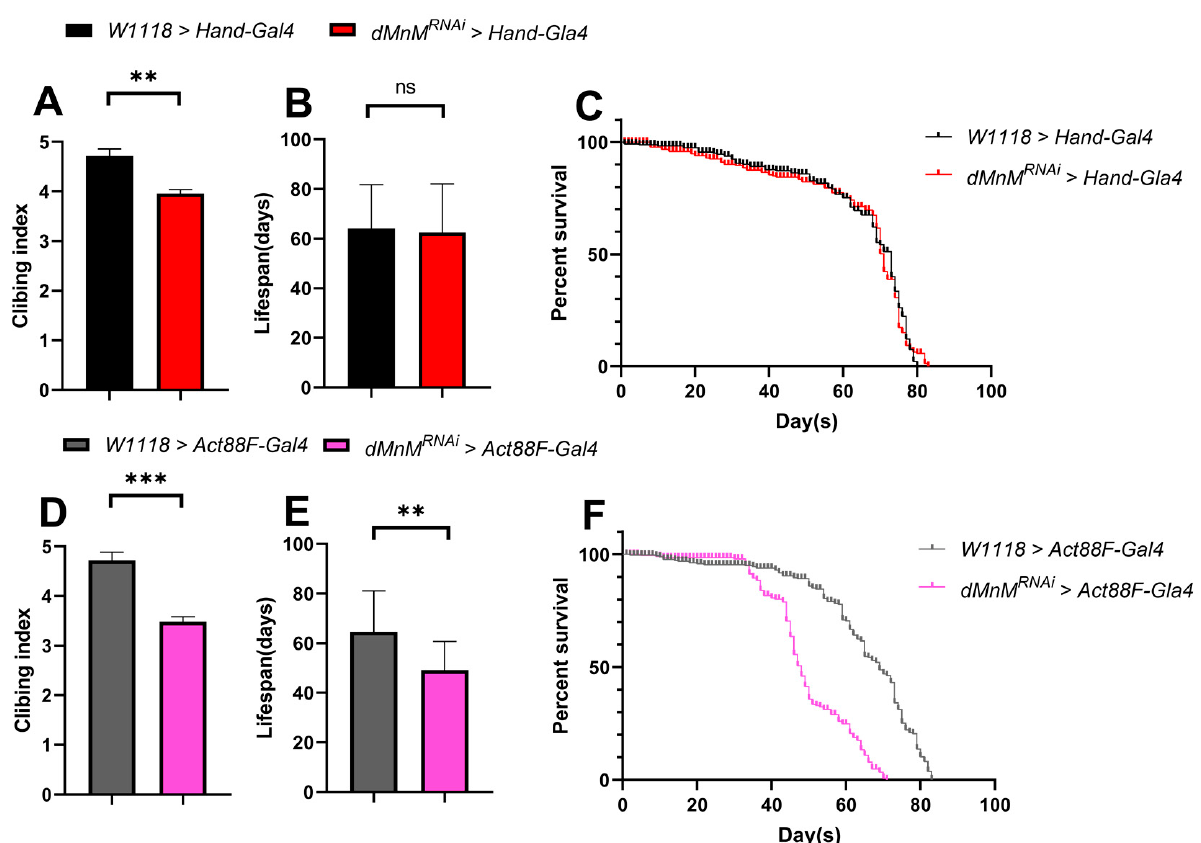
Figure 4. Effects of dMnM knockdown in cardiomyocytes and IFM on climbing and lifespan of Drosophila . ( A ) Climbing results for the W1118 > Hand-Gal4 group; ( B , C ) lifespan and survival curves for the W1118 > Hand-Gal4 group and dMnM RNAi > Hand-Gal4 group, respectively; ( D ) climbing results for the W1118 > Act88F-Gal4 and dMnM RNAi > Act88F-Gal4 group; ( E , F ) lifespan and survival curves for dMnM RNAi > Hand-Gal4 group, respectively. Climbing sample n = 100; lifespan sample n = 200. The difference between the two groups was tested using an independent-samples t -test, ** p < 0.01, *** p < 0.001, ns is not statistically significant.